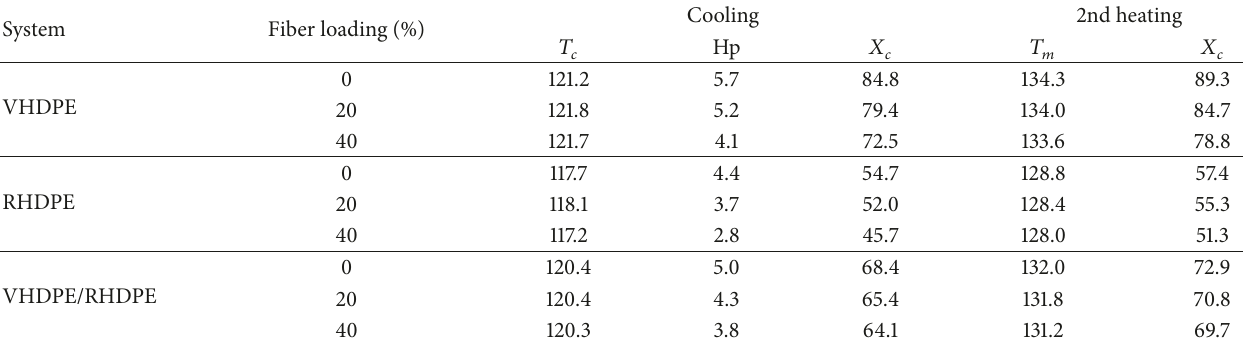
Table 2: DSC result of VHDPE/fiber, RHDPE/fiber, and VHDPE/RHDPE/fiber composite.